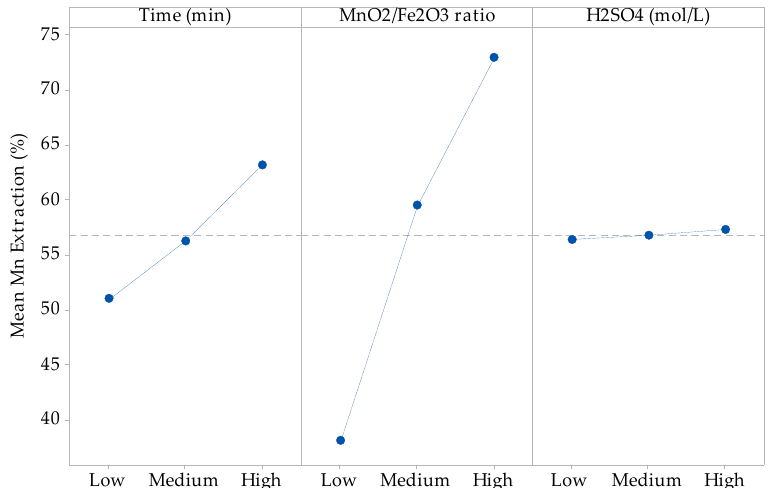
Figure 2. Linear effect plot for Mn extraction (%).